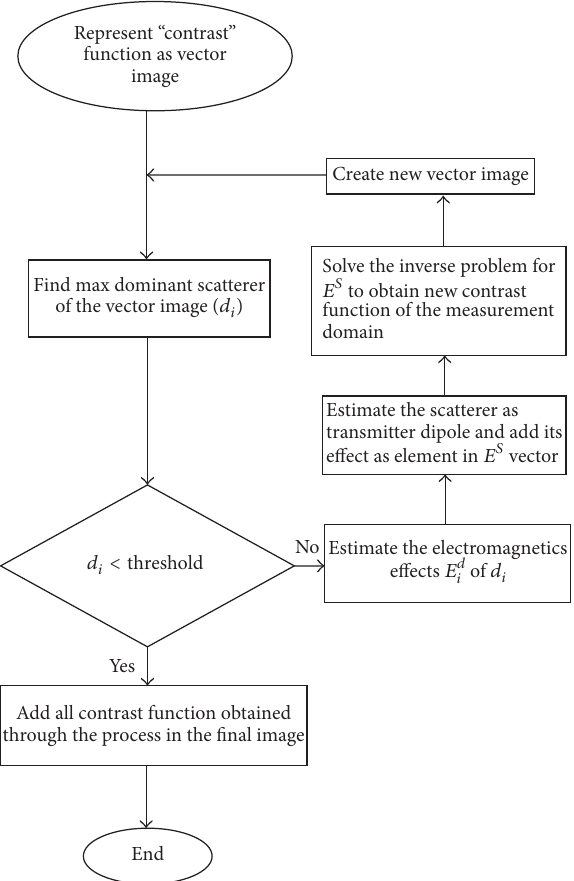
Figure 5: The flowchart of the proposed algorithm.